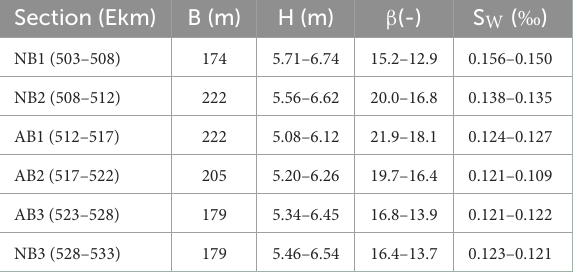
TABLE 1 Sections used to apply bar predictors and their